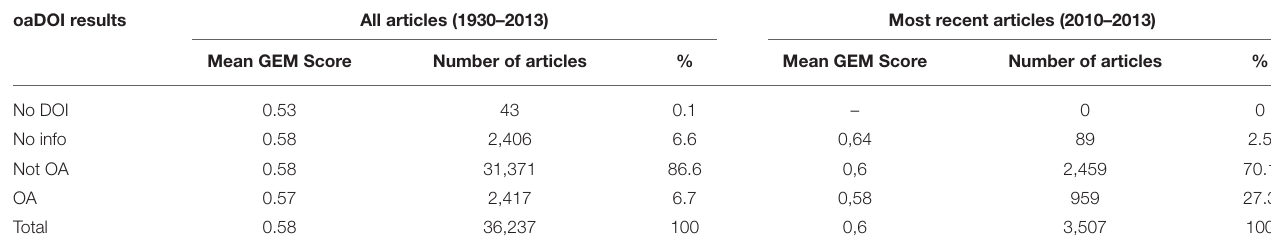
TABLE 6 | Mean GEM score and open access status over two time periods.